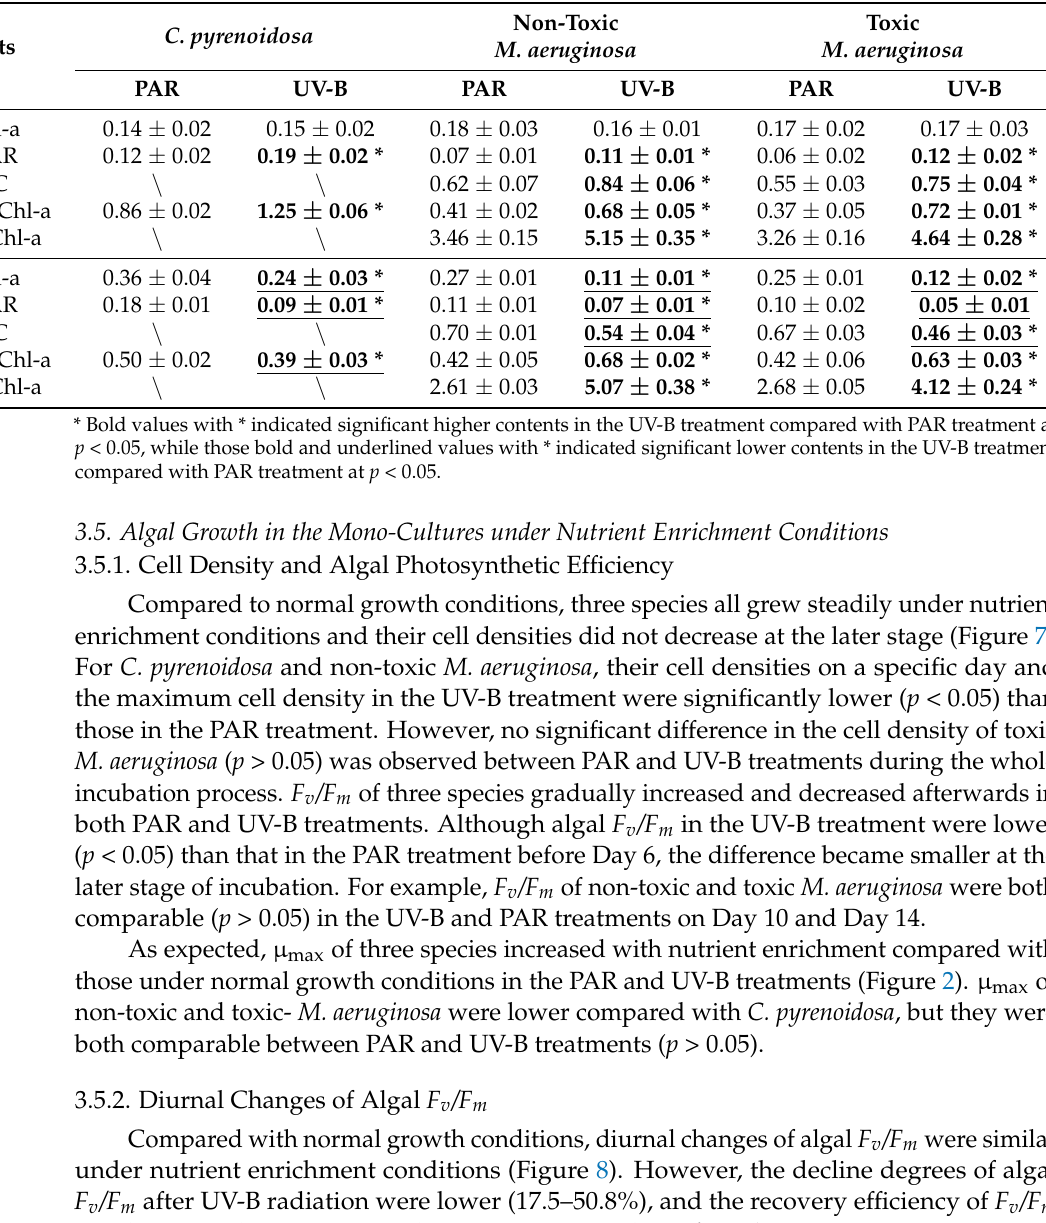
Table 1. Contents of photosynthetic pigments of three species in the PAR and UV-B treatments on Day 1 and Day 8 under normal growth